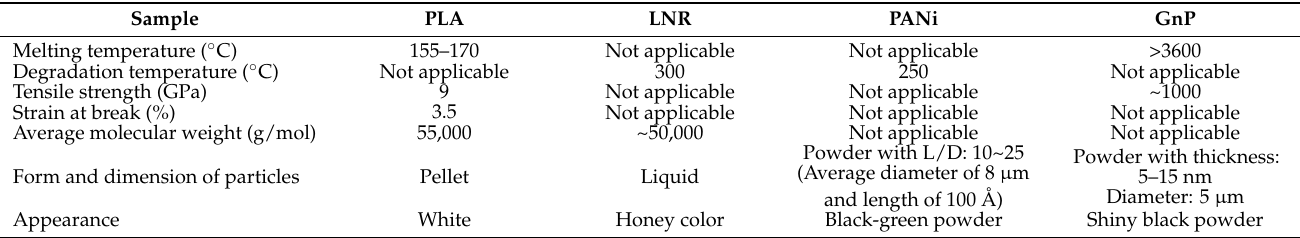
Table 1. Properties of raw materials used in nanocomposite